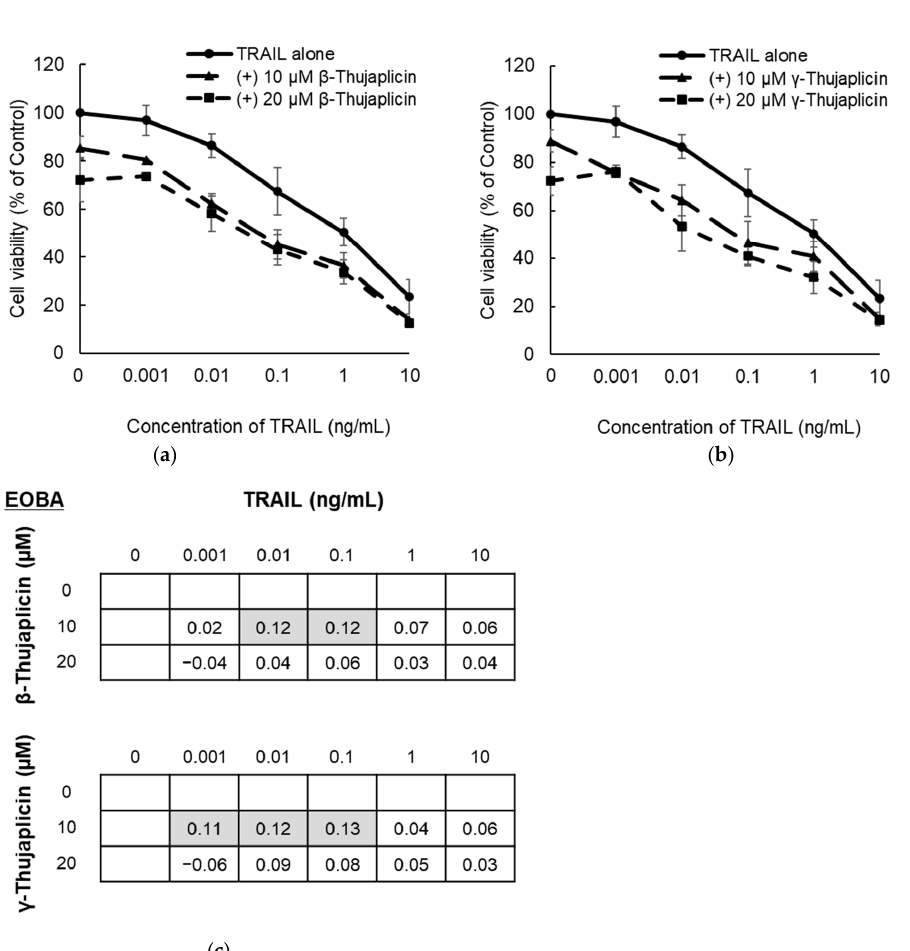
Figure 2. Quantitation of cell viability by trypan blue staining following tropolone, β -thujaplicin, and γ -thujaplicin treatments on NCI-H460 cells at the indicated concentrations for 24 h. Cell viability (% of control) was measured using a trypan blue exclusion assay. Data are the averages of three independent experiments and error bars show the standard deviation. * p < 0.05 and ** p < 0.01 compared with untreated NCI-H460 cells (Ctrl).